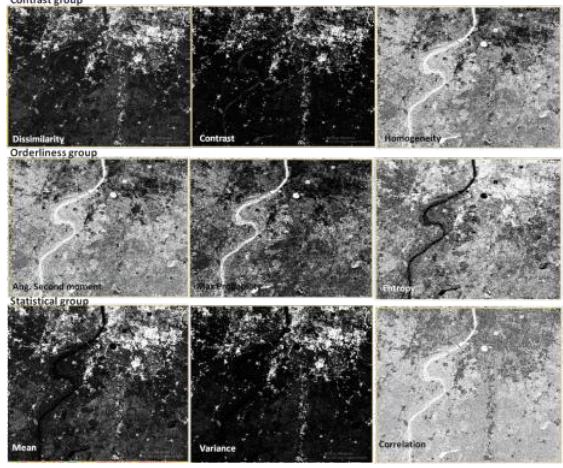
Figure 3. GLCM texture measures generated from Radarsat- 2 HH